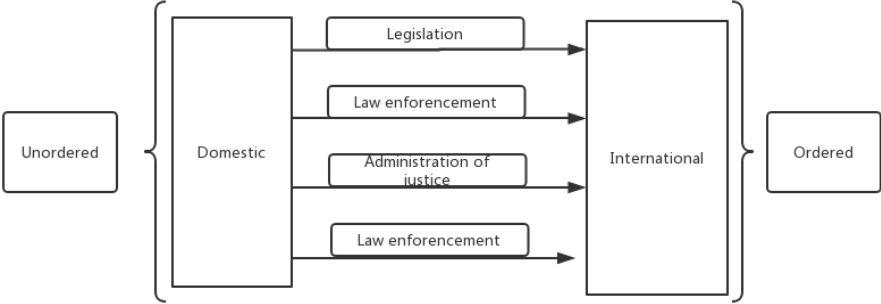
Figure 2. The rule of law for global governance of illegal logging and trade in forests.